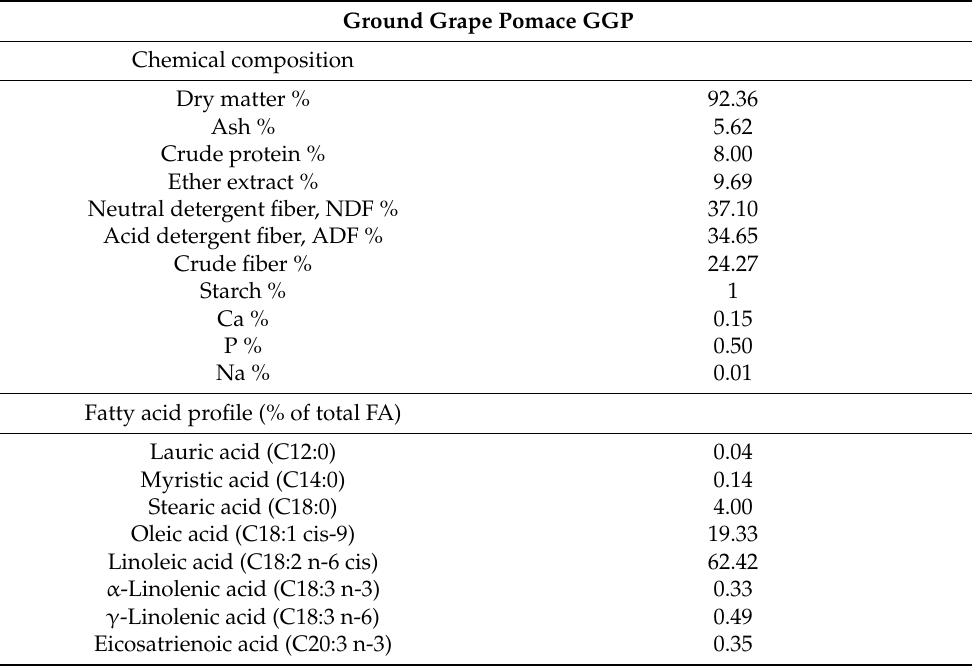
Table 4. Chemical composition (%) and fatty acid profile of ground grape pomace